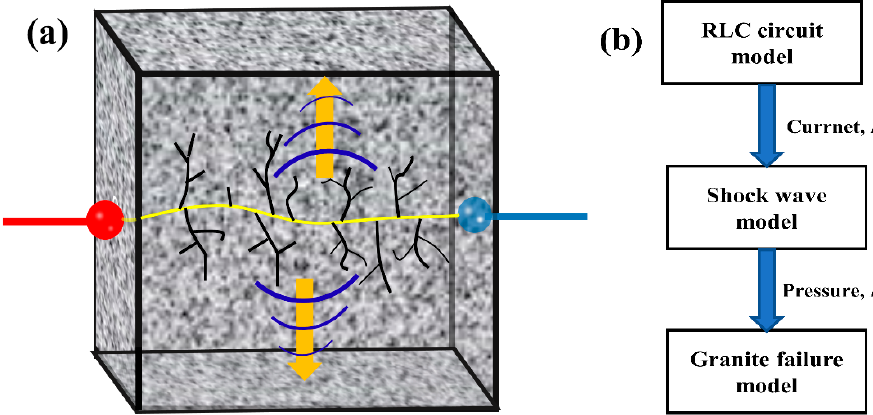
Figure 2. ( a ) Granite broken forms and ( b ) broken process under electropulse.